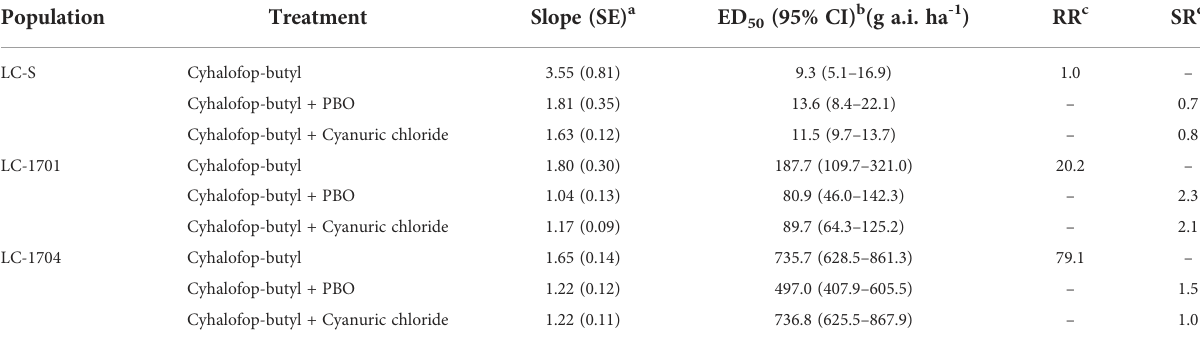
TABLE 2 Synergistic effects of enzyme inhibitors on cyhalofop-butyl toxicity in different Leptochloa chinensis populations.